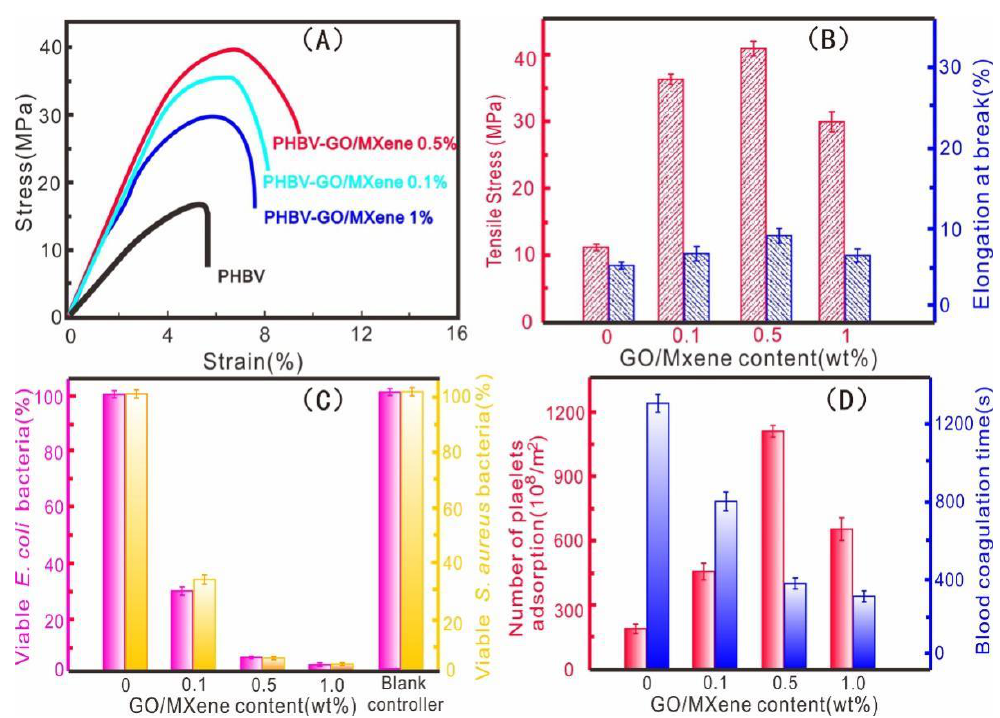
Figure 7. Stress-strain curves ( A ), elongation at break ( B ), antibacterial activity at 24 h and ( C ) platelet adsorption and blood coagulation time ( D ) of PHBV of PHBV, PHBV—GO/MXene 0.1%, PHBV—GO/MXene 0.5% and PHBV—GO/MXene 1% composite membranes.